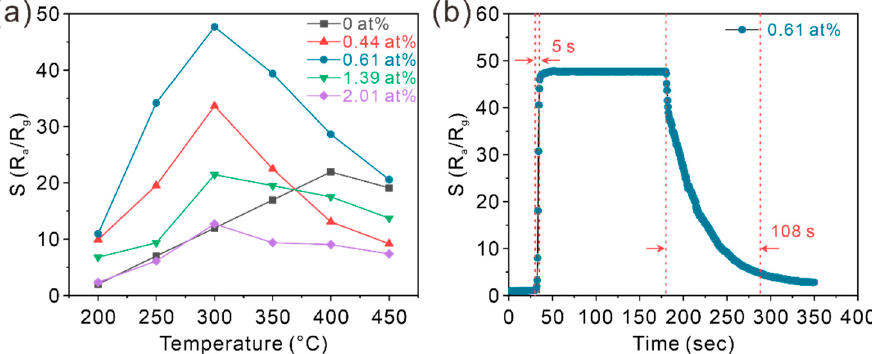
Figure 5. ( a ) The relative response of porous ZnO nanobelts doped with different amounts of Pb toward 50 ppm of n-butanol at different working temperatures. ( b ) The real-time response curve of 0.61 at% Pb-doped ZnO porous nanobelts toward 50 ppm of n-butanol at 300 ◦